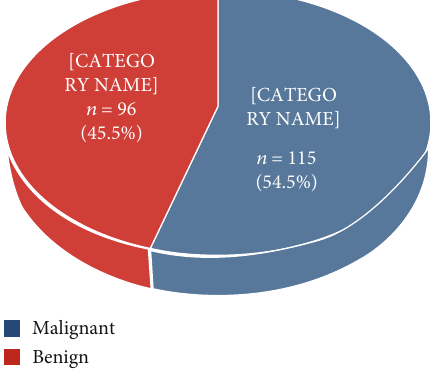
Figure 1: Pie chart showing histology report of prostate